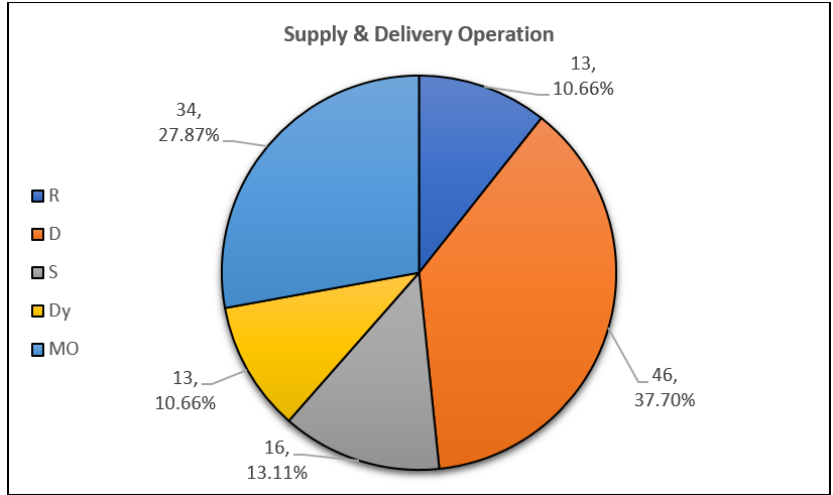
Figure 20. Breakdown of VRP for Supply & Delivery Operation based on Modelling